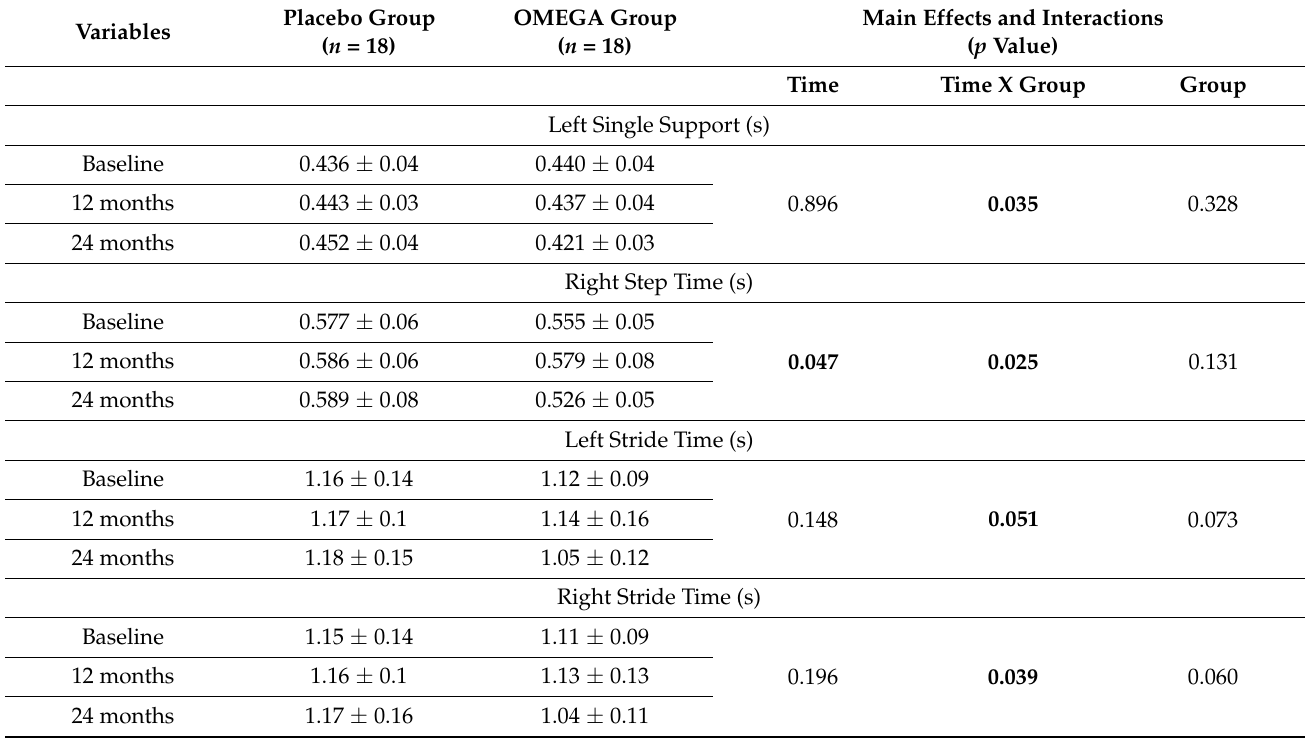
Table 2. Normalized spatiotemporal gait parameters of the left and right leg in both groups for all three time-points, excluding the